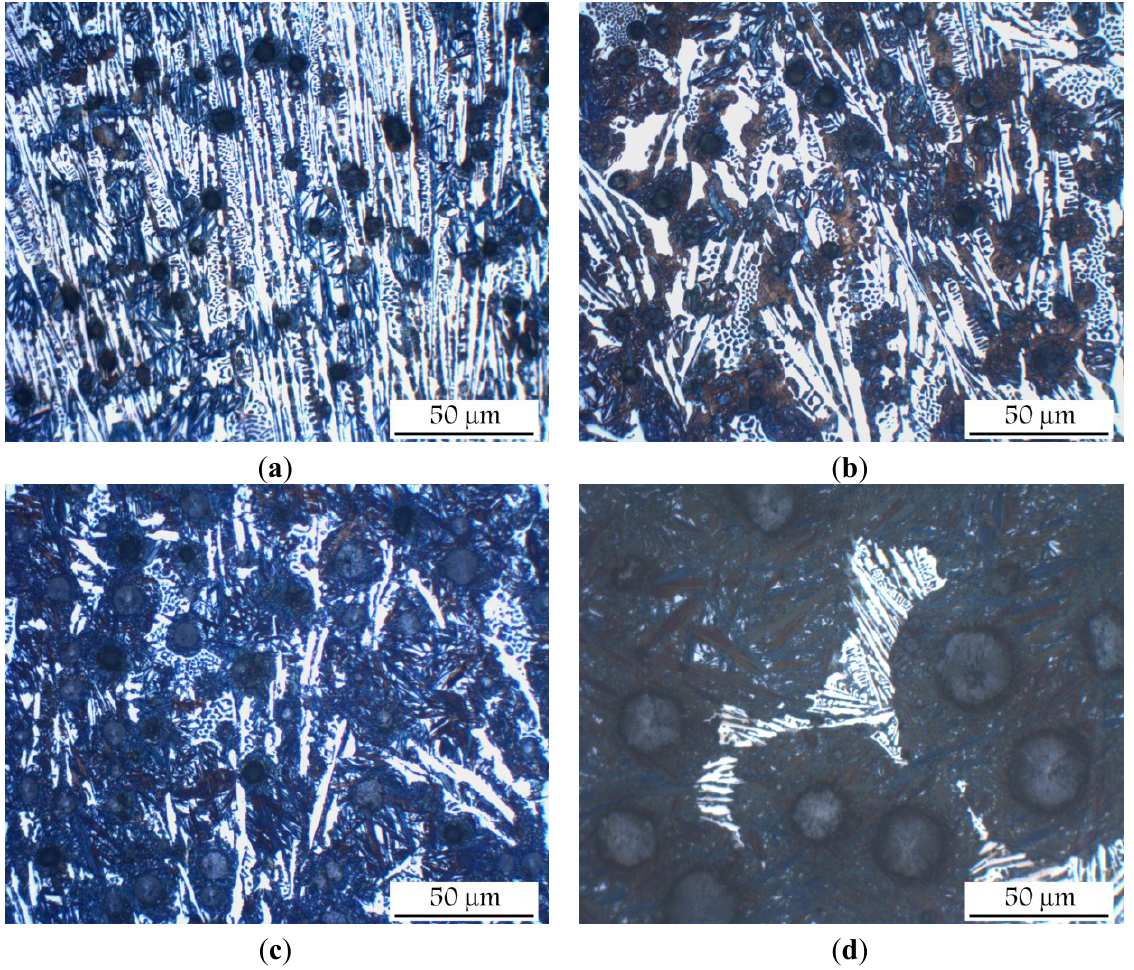
Figure 5. Solid fraction evolution of B1 samples. ( a ) B11 Sample; ( b ) B12 Sample;